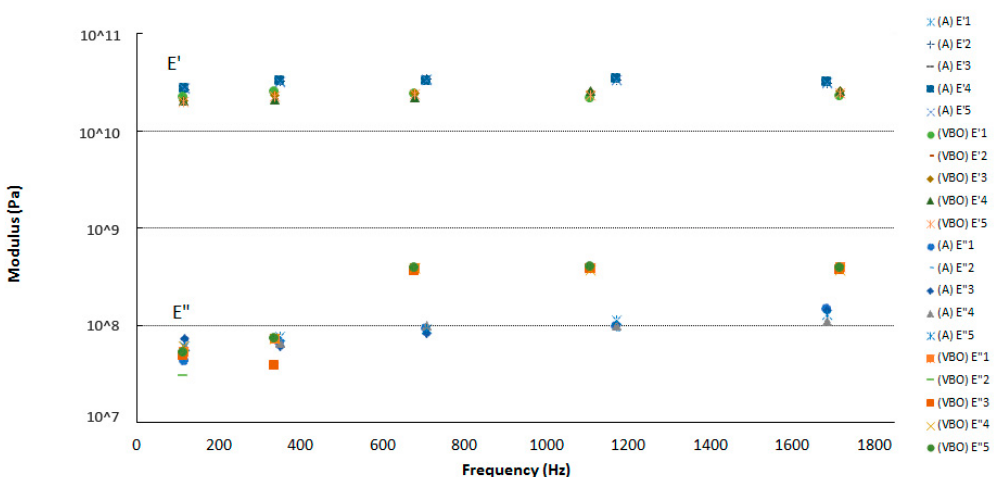
Figure 9. Loss and storage modulus results for CFRE prepregs: A (autoclave) and VBO (vacuum bag-only).